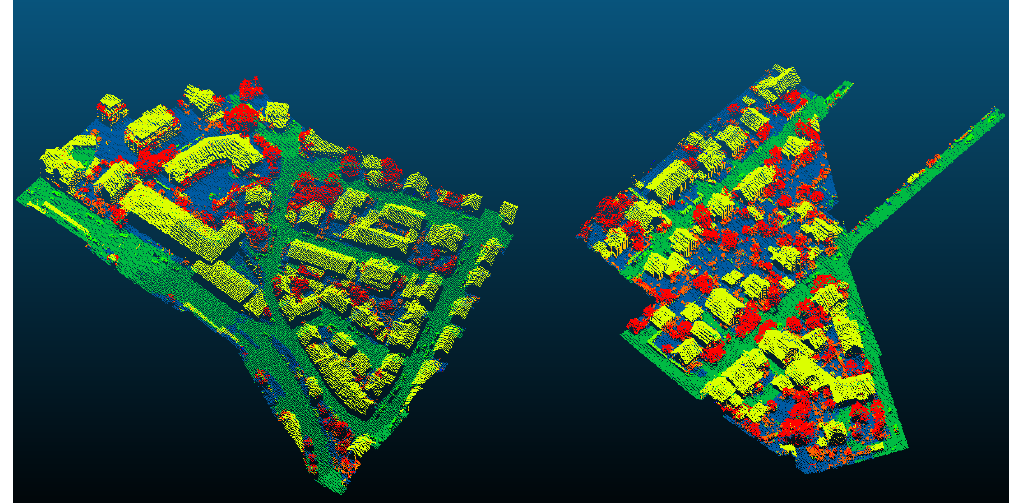
Figure 5. The classification result of the CNN_DEIV.